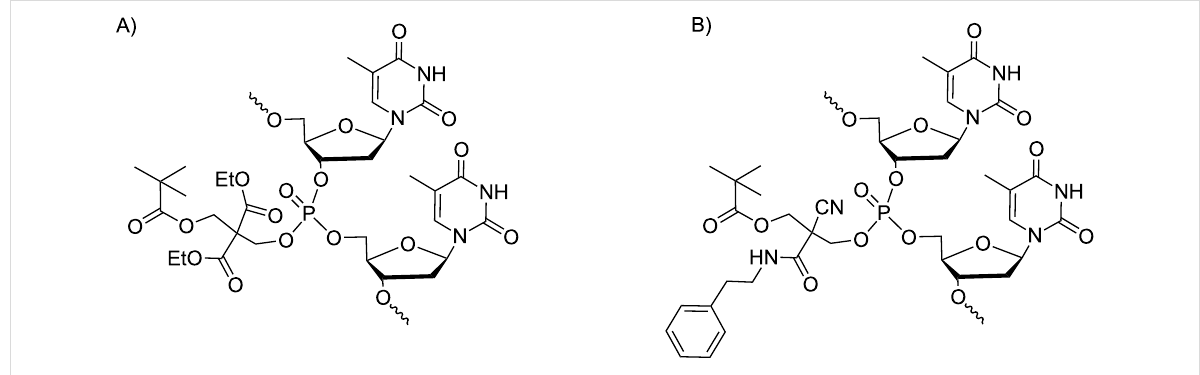
Figure 1: Oligothymidylates bearing A) 2,2-bis(ethoxycarbonyl)-3-(pivaloyloxy)propyl- and B) 2-cyano-2(2-phenylethylaminocarbonyl)-3- (pivaloyloxy)propyl phosphate protecting groups [41].